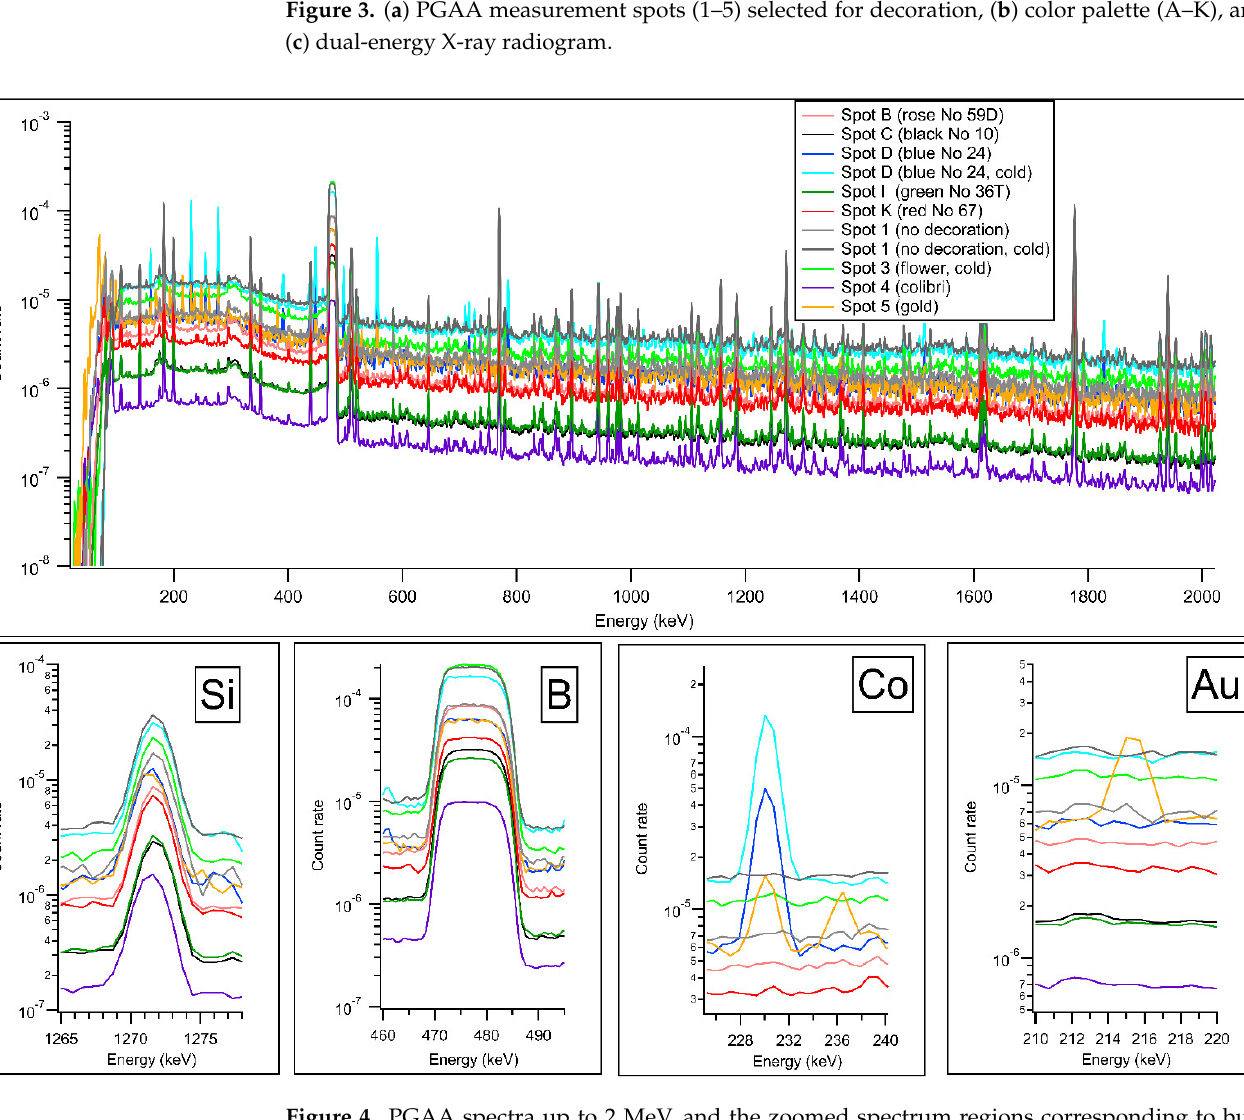
Figure 4. PGAA spectra up to 2 MeV, and the zoomed spectrum regions corresponding to bulk components Si, B, as well as elements Co and Au present in the surface decoration. PGAA data were taken with thermal neutron beam unless indicated otherwise in the legend.